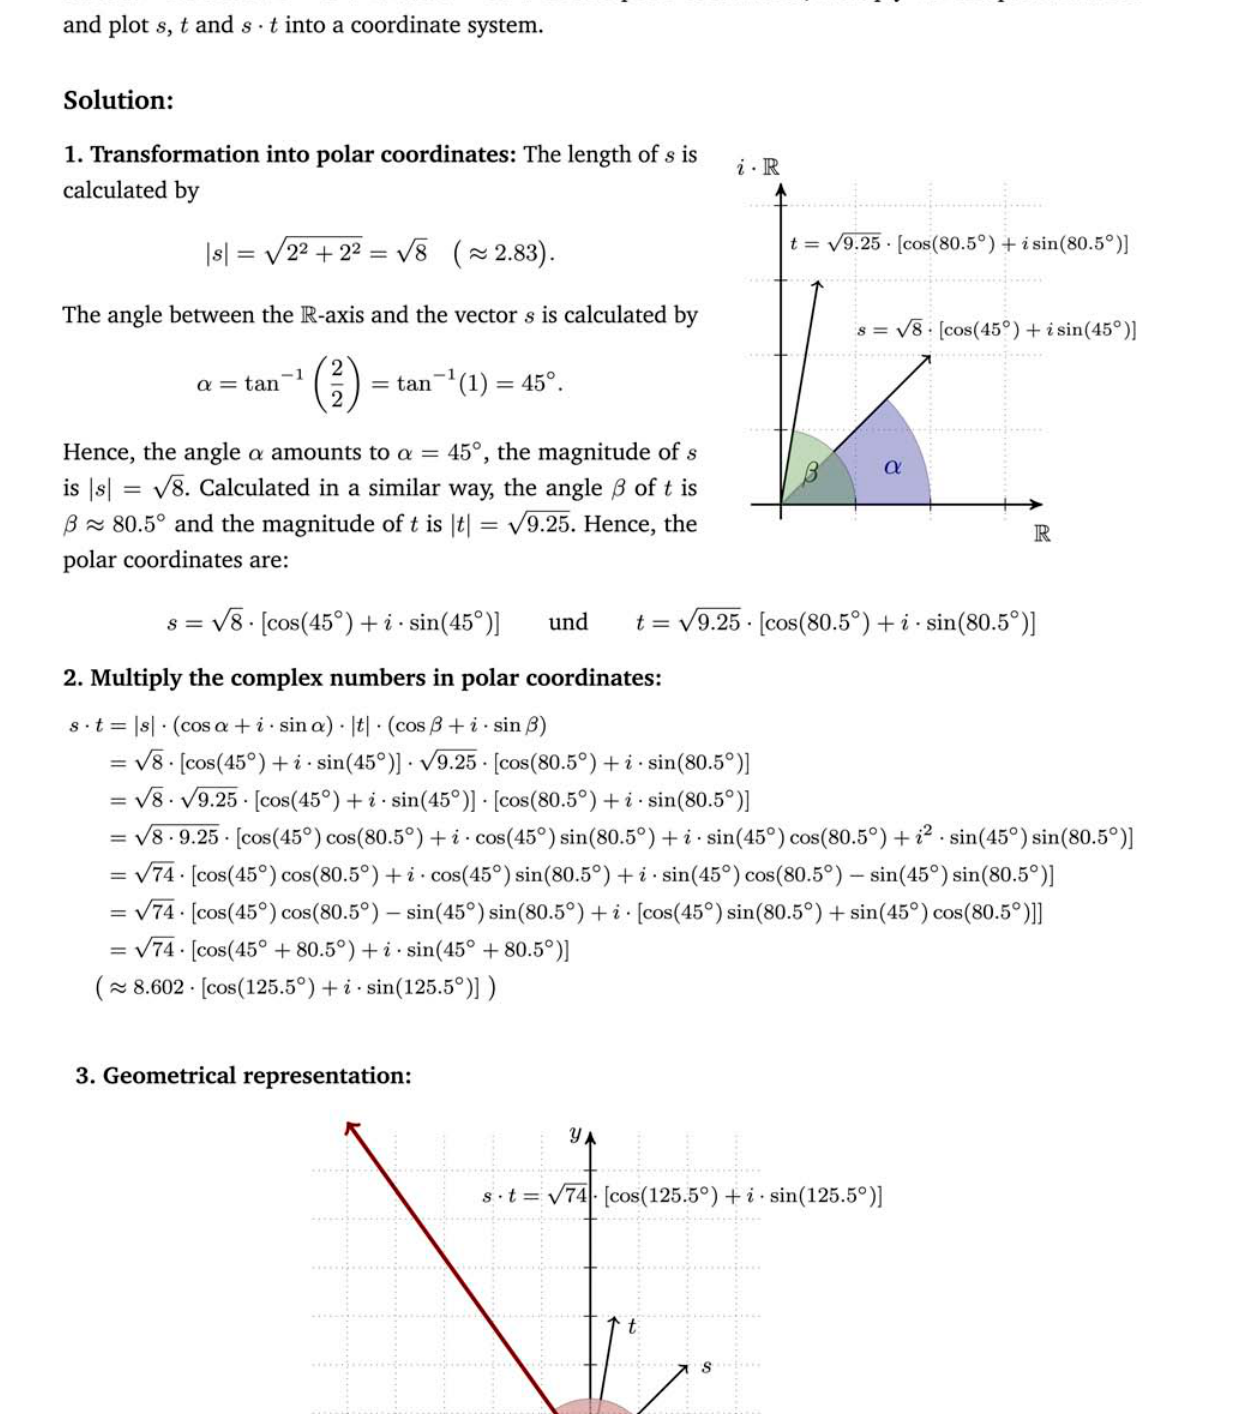
Frontiers in Psychology |